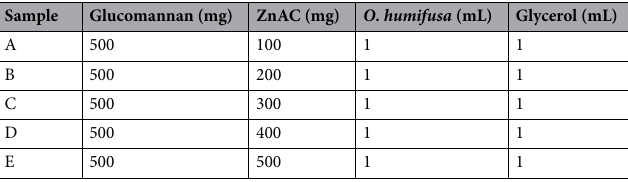
Table 4. Different formulations of hand gels investigated in this